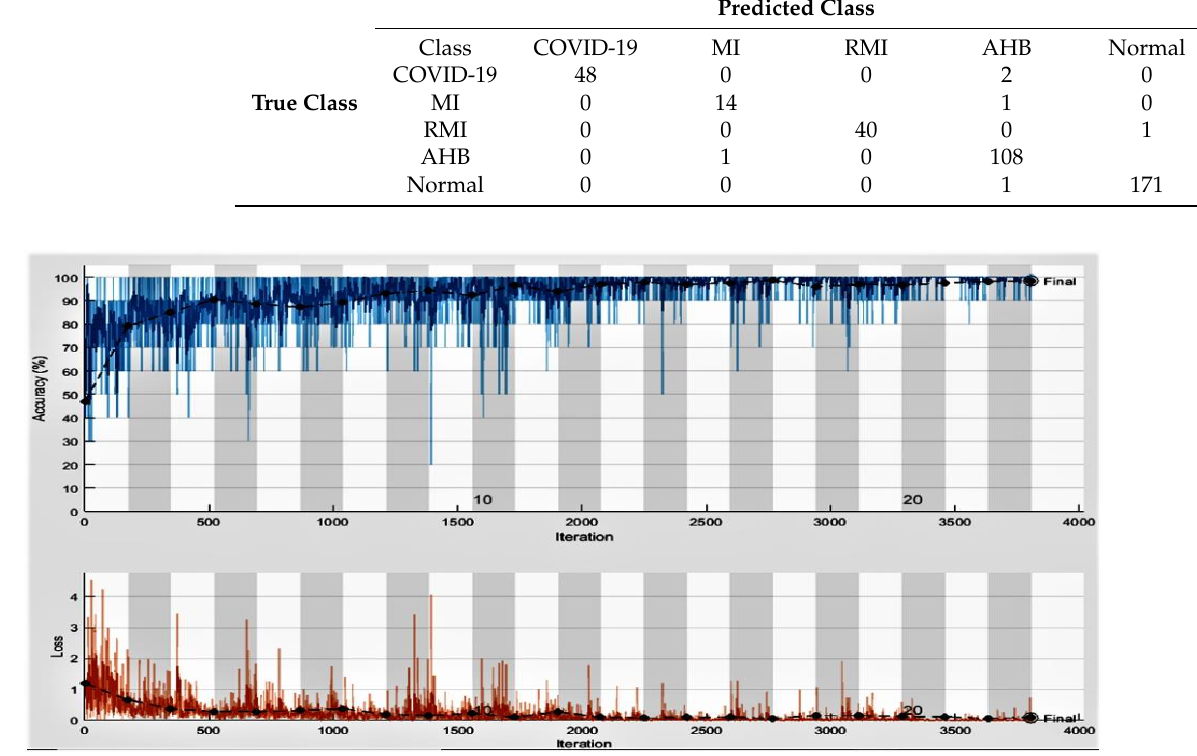
Table 10. Confusion matrix attained by ShuffleNet in five-class classification scheme using ECG images. Table 9. Confusion matrix attained by ShuffleNet in three-class classification scheme using ECG images.